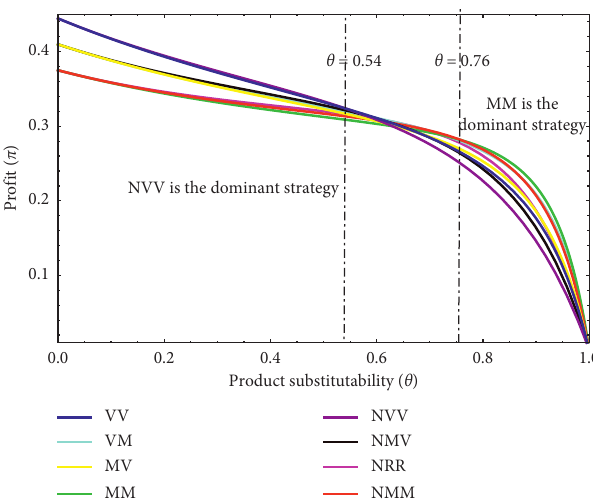
Figure 9: Comparison with respect to the entire of supply chain efficiency among all